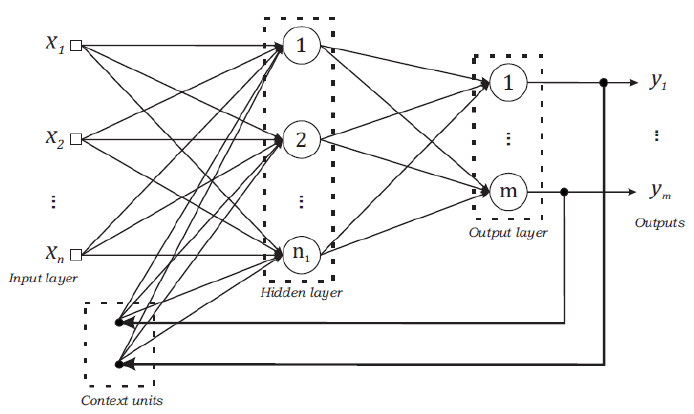
Figure 2. Jordan network.